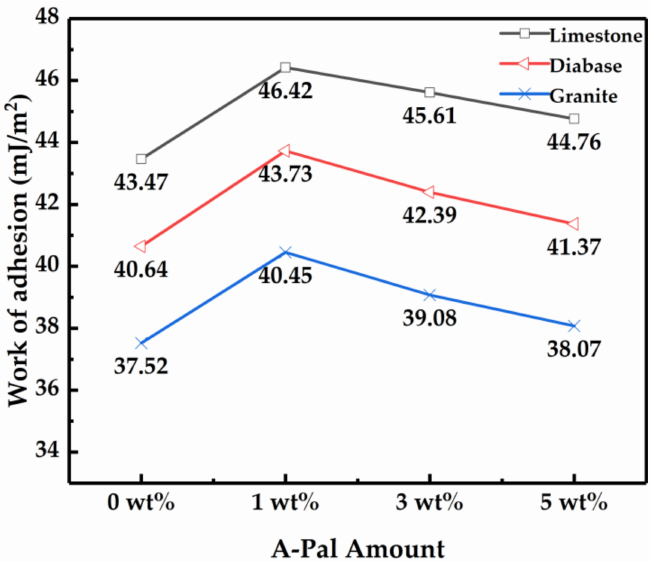
Figure 3. Adhesion work of modified asphalt with different amounts of A-Pal. The work of peeling (W asw ) indicates the rate at which the asphalt spontaneously spalls from the surface of the mineral. The W asw was the opposite of the Gibbs free energy change. The larger the W asw is, the faster the asphalt peels off from the surface of the mineral material, and the faster water damage occurs. The W asw was calculated by Equation (5), and the results are shown in Figure 4. The alkaline aggregate limestone has better anti-flaking ability and stronger water damage resistance within the test range. It has been mentioned in many research studies that alkaline aggregate has a good bonding effect with asphalt, and an obvious anti-spalling effect [18,20,27]. For the different amounts of A-Pal, the effect of A-Pal-compounded SBS-modified asphalt and mineral materials on the exfoliation work was not obvious. The peeling work was basically the same with each dosage.